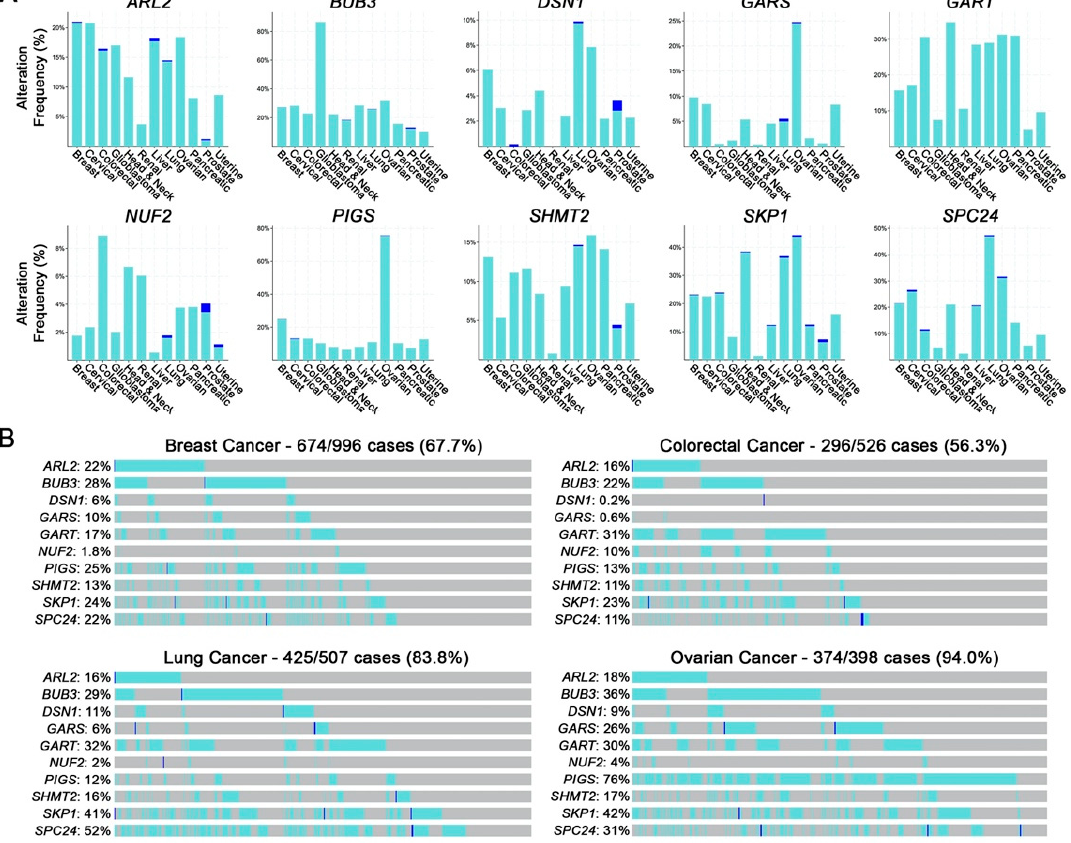
Figure 2. Hypomorphic CIN Gene Alterations are Frequently Observed in Cancer. ( A ) Frequency of gene copy number alterations in 12 common cancer types with shallow (heterozygous) and deep (homozygous) deletions indicated in aqua and blue, respectively. Data were extracted from publicly available TCGA datasets [19]. ( B ) Cumulative frequency of shallow and deep deletions for all 10 genes in breast (67.7%), colorectal (56.3%), lung (83.8%) and ovarian (94.0%) cancers. The frequency of individual gene alterations for each cancer is indicated.